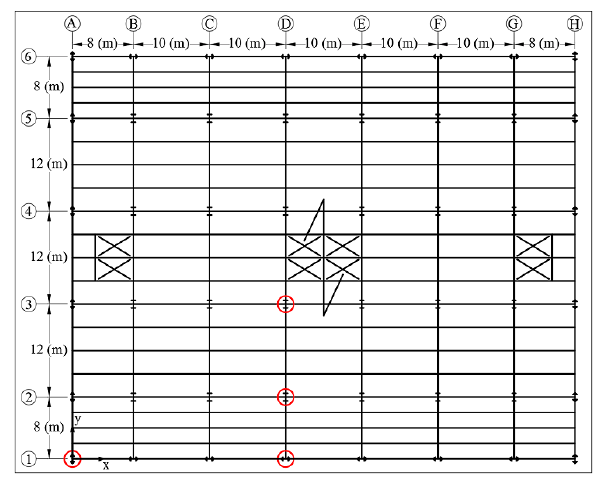
Figure 1. Plan view of the fifteen-story steel-framed building.